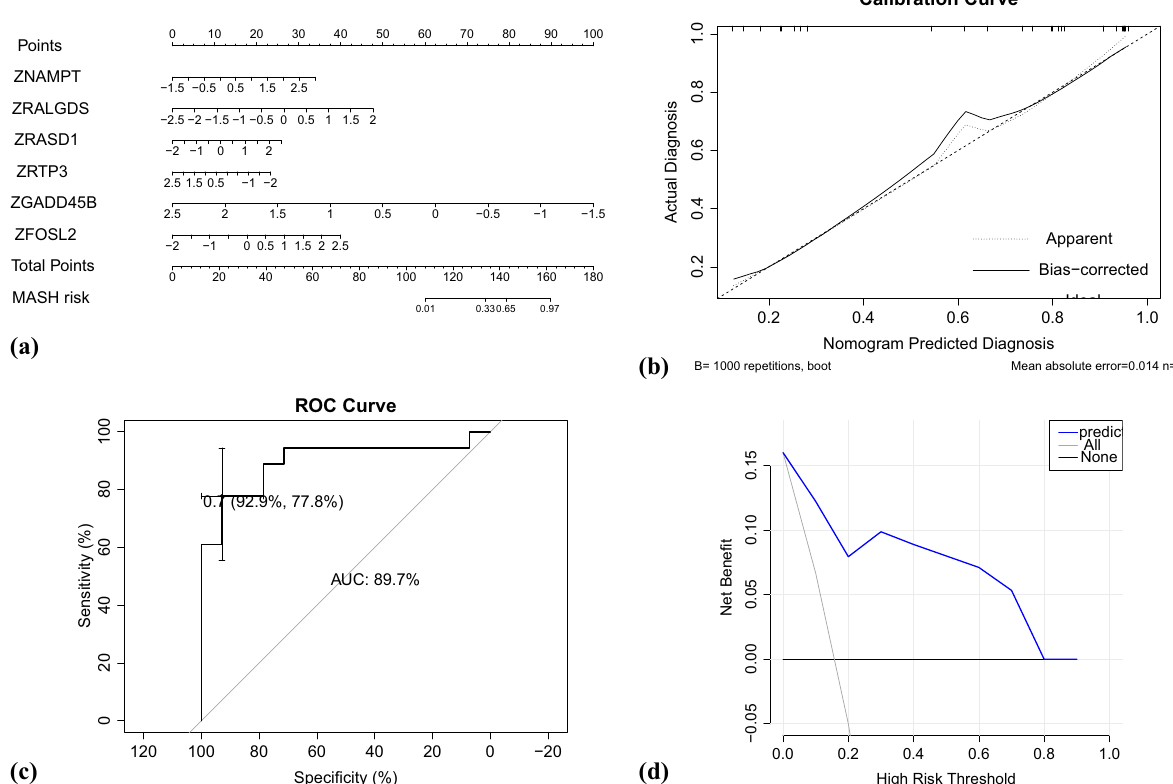
Figure 4: Statistical analysis for the prediction nomogram model. ( a ) Nomogram for distinguishing MASH and simple steatosis. All hub genes were Z - score normalized, and ZNAMPT meant the normalization data of NAMPT, and so on. ( b ) The calibration plot of the nomogram. The horizontal axis presented the predicted MASH, and the vertical axis was the actual diagnosis. The bias corrected line indicated the performance of the nomogram. ( c ) ROC curve of the model for the dataset GSE48452 to discriminate patients with simple steatosis from patients with NASH. ( d ) Decision analysis curve of the model for the dataset GSE48452. The horizontal axis was the threshold probability for NASH, and the probability of samples being NASH was calculated based on the prediction model. When the probability of the sample being NASH was more than the threshold probability, the sample was considered as NASH according to the model. The vertical axis was the net bene fi t. Gray line represented the net bene fi t of that all samples were NASH and were received the treatment for NASH. Black line represented the net bene fi t of that all samples were simple steatosis and forwent the treatment for NASH. Blue line represented the net bene fi t of that NASH samples predicted by the model received the treatment for